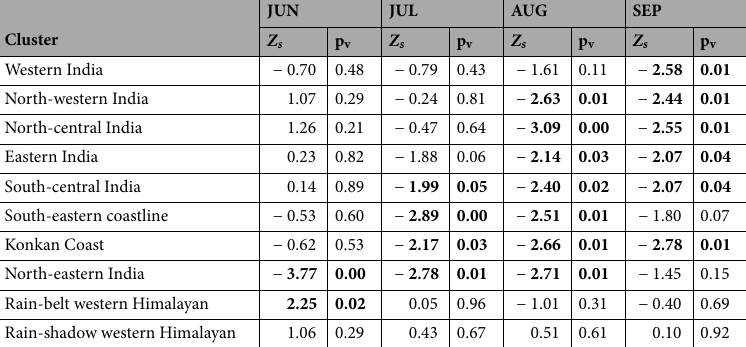
Table 2. Same as Table 1 but for CWCE spatial